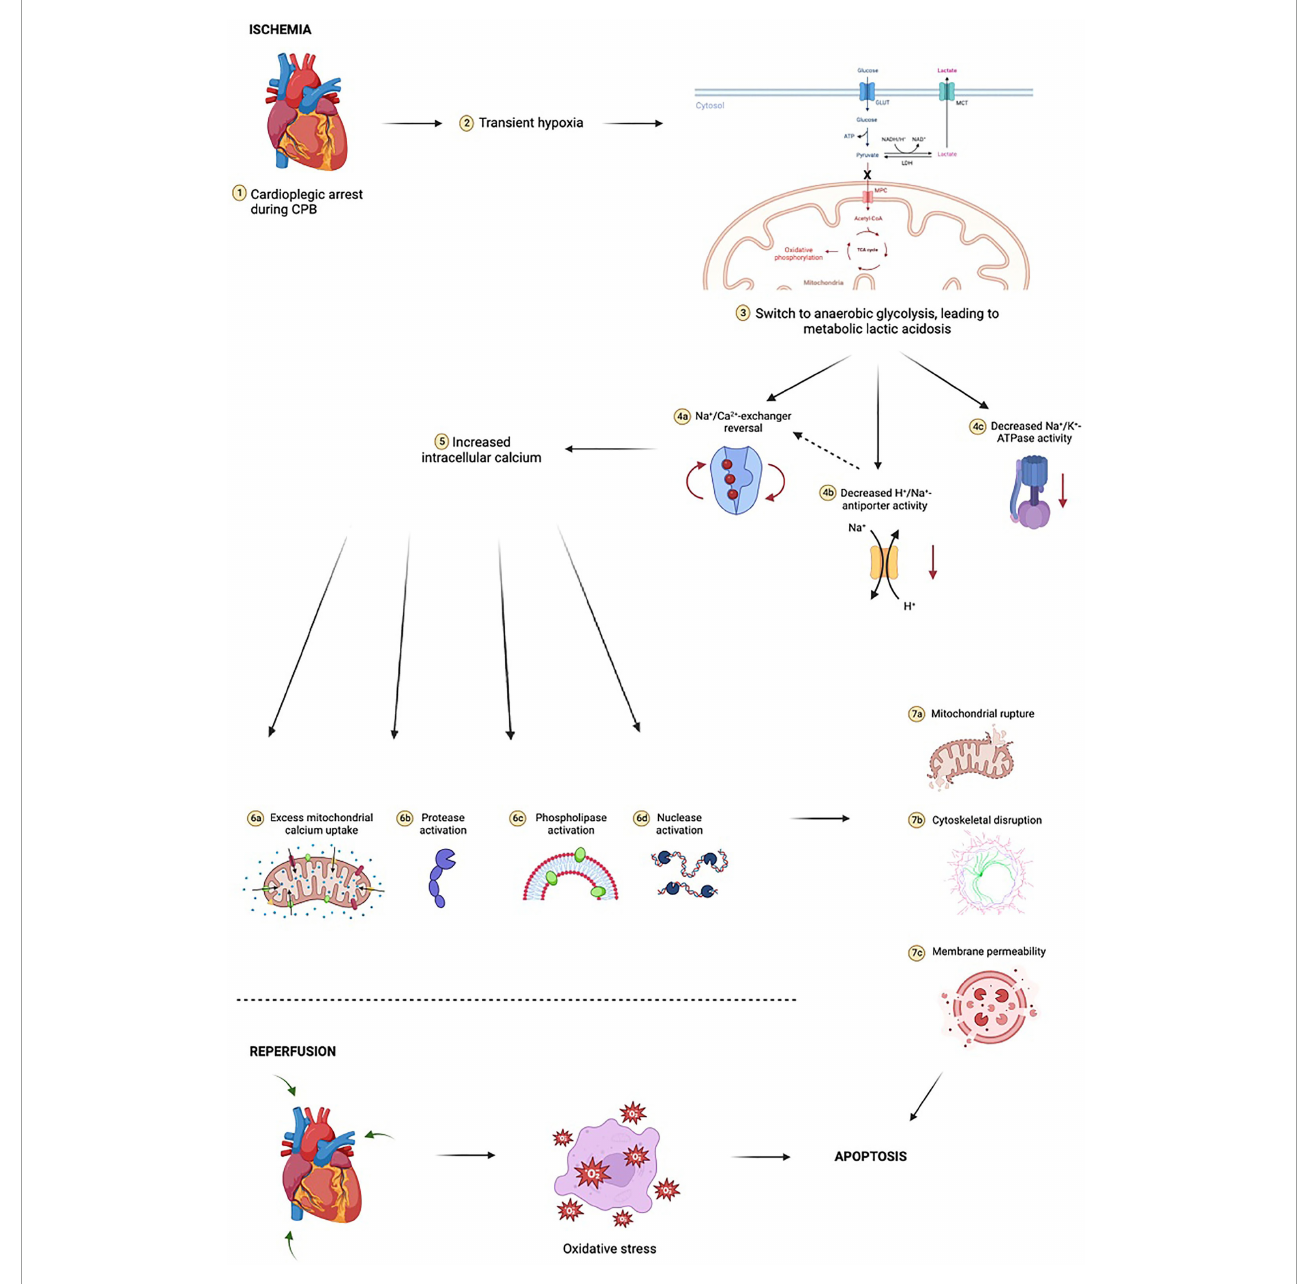
FIGURE2 Ischemia-reperfusion injury is complex and multifactorial. At the cellular level, initial transient hypoxia due to cardiopulmonary bypass (CPB) leads to a switch from mitochondrial oxidative phosphorylation to anaerobic glycolysis, with a marked reduction in ATP yield. In poorly oxygenated tissues, pyruvate (the end-product of glycolysis) is shunted away from mitochondria and instead undergoes conversion to lactate by cytosolic lactate dehydrogenase (LDH). The resulting lactic acidosis in combination with high extracellular potassium and hypothermia due to cold cardioplegia inhibits the activity of Na + /K + -ATPase, an enzyme critical for maintaining physiologic resting membrane potential of cardiomyocytes close to the Nerst equilibrium potential of potassium (approximately –85 to –90 millivolts). Metabolic acidosis dually increases H + /Na + -antiporter activity, resulting in a small but notable increase in intracellular sodium, further exacerbating the sodium “window current” phenomenon during hyperkalemic cardioplegia. These electrochemical events drive the new membrane potential closer to –50 millivolts. The Na + /Ca 2 + -exchanger begins to operate in reverse, moving three Na + ions out of the cardiomyocyte for every Ca 2 + ion in. Voltage-gated slow calcium channels also begin to activate, leading to further calcium influx. This myocardial calcium loading in turn activates proteases, nucleases, and phospholipases, resulting in phospholipid membrane degradation, organelle destruction, accumulation of catabolic byproducts, compromised ultrastructural integrity of sarcolemma membrane integral to calcium homeostasis, and accelerated depletion of intracellular ATP stores. Prolonged exposure to ischemia increases mitochondrial calcium uptake through reversal of mitochondrial Na + /Ca 2 + -exchanger in a manner akin to reversal of cardiomyocyte Na + /Ca 2 + -exchanger. This leads to critical and irreversible damage to mitochondria. Following reperfusion, mitochondria have reduced capacity for neutralizing reactive oxygen species (ROS) and contribute to sustained oxidative stress by way of ROS production. This mitochondrial oxidative stress occurs in both cardiomyocytes as well as in the microvasculature, compounding the effects. Cytosolic cytochrome c is implicated in activating caspases involved in intrinsic apoptotic pathways. Reperfusion results in additional cardiac injury independent of ischemic insult which manifests as dysrhythmia, myocardial stunning, and myocardial necrosis. Notably, concurrent oxidative stress within the microvasculature results in microvascular dysfunction, further compounding cardiac injury. Figure created using